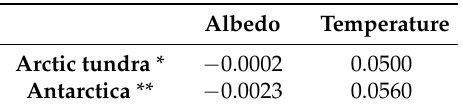
Table 1. Comparison of variation of albedo and temperature between Arctic tundra (Chapin et al. [10]) and Antarctica (this study). Albedo Temperature Arctic tundra * − 0.0002 0.0500 Antarctica ** − 0.0023 0.0560